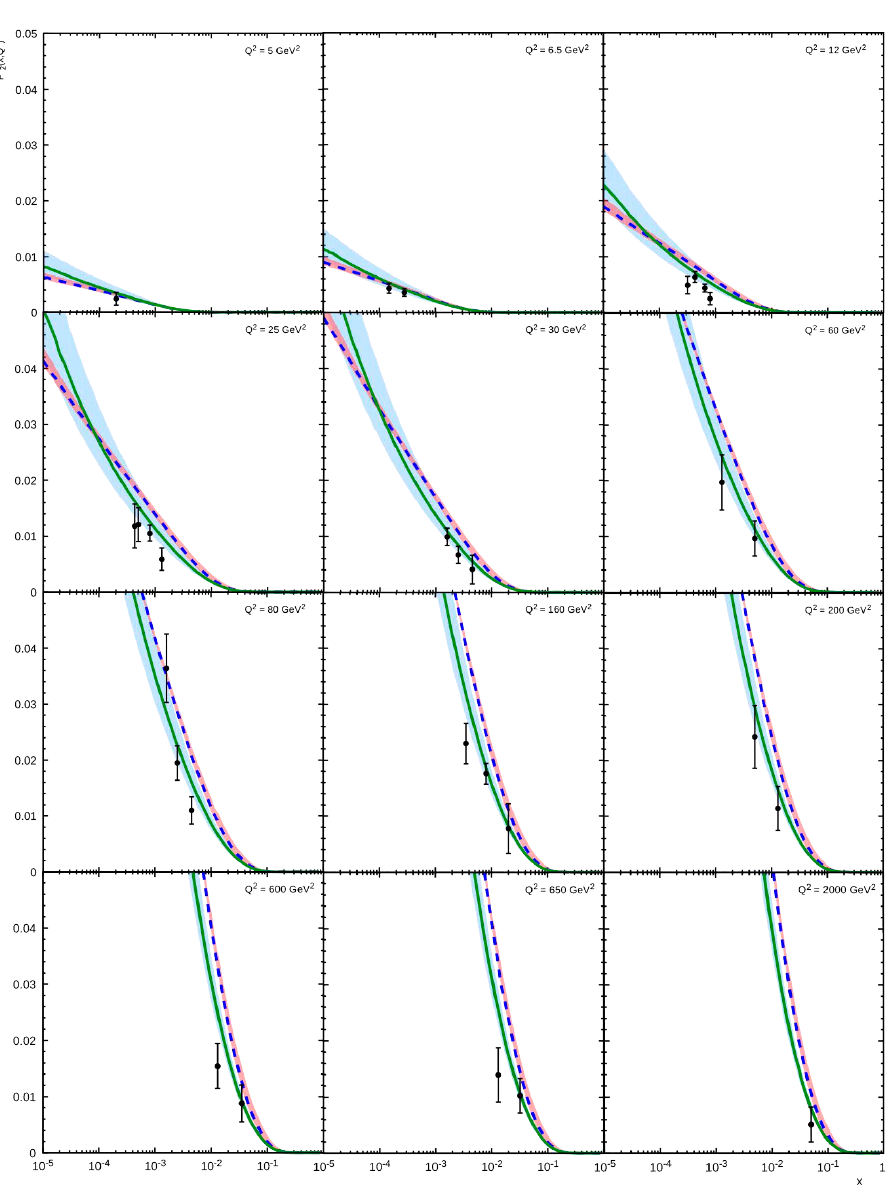
Figure 3. The beauty contribution to the proton structure function F 2 ( x, Q 2 ) as a function of x calculated at different Q 2 . Notation of the histograms is the same as in Fig. 1. The experimental data are from ZEUS [21] and H1